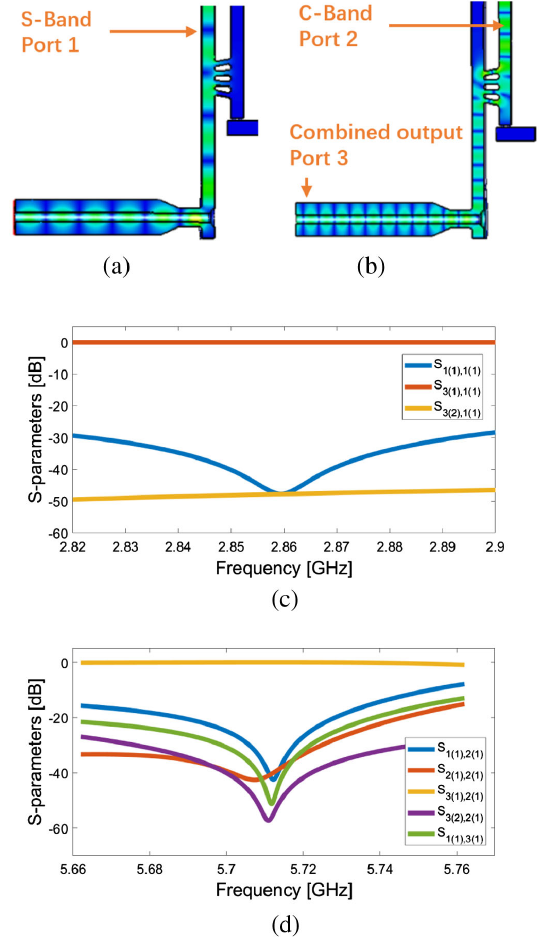
FIG. 2. The contour map of the electrical field distribution of the waveguide assembly and S-parameters. (a) Excited by S-band (b) Excited by C-band (c) S-parameters of the assembly excited by S-band (d) S-parameters of the assembly excited by C-band.